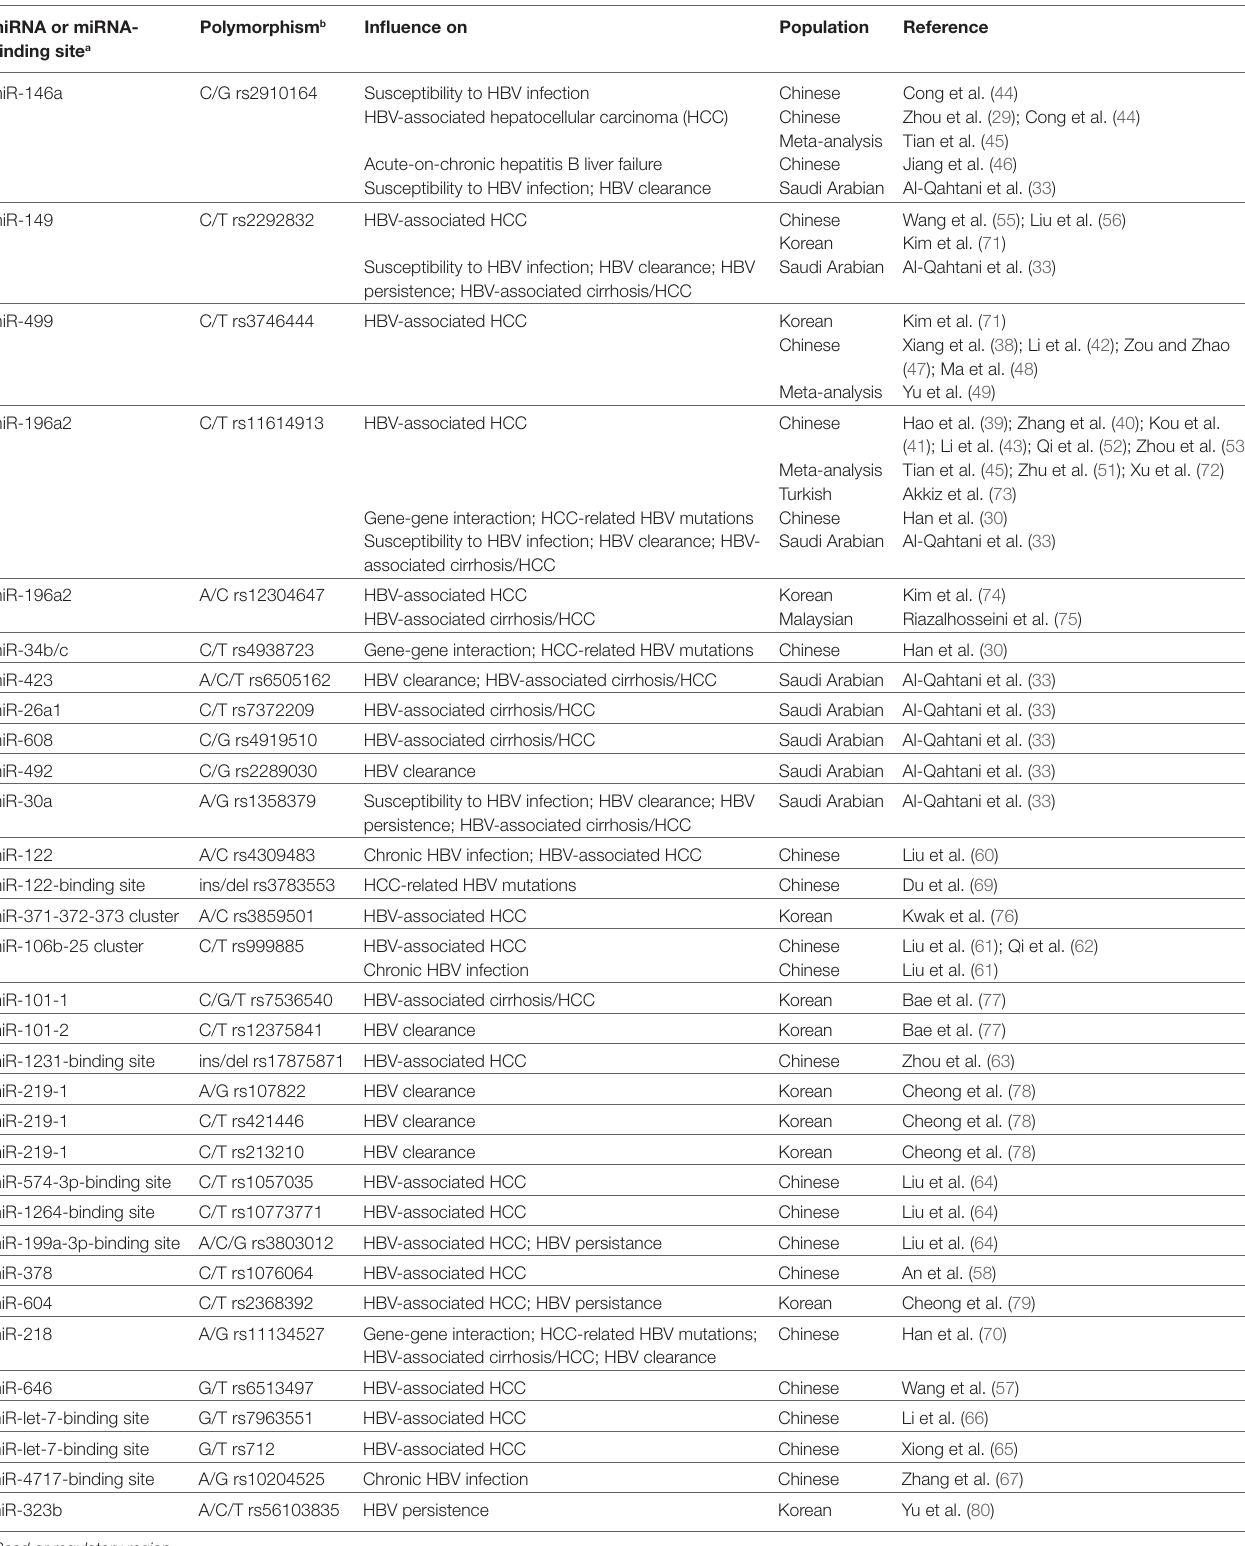
a Seed or regulatory region. b Polymorphism quotations were standardized according to the Single Nucleotide Polymorphism Database (dbSNP) of NCBI (https://www.ncbi.nlm.nih.gov/snp/), based on the reference SNP cluster (rs#) of each